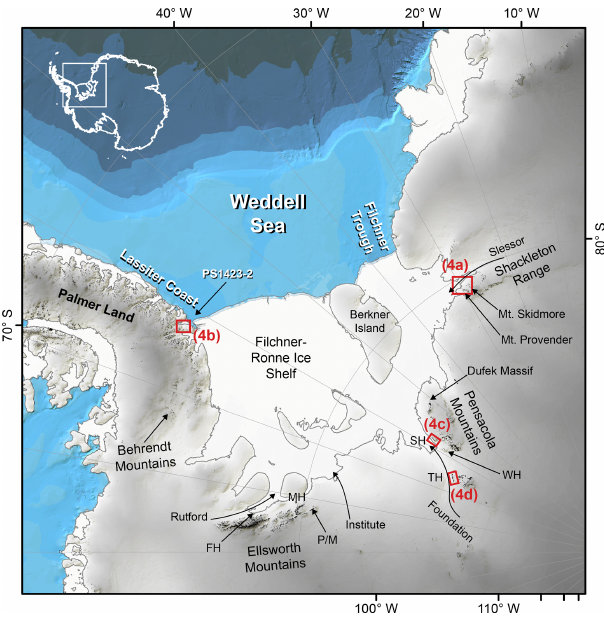
Figure 1. The Weddell Sea Embayment, including all locations referred to within the text. SH, WH, and TH are the Schmidt, Williams, and Thomas Hills, respectively. FH, P/M, and MH are the Flower Hills, Patriot and Marble Hills, and the Meyer Hills, re- spectively. Black is exposed rock. Red boxes show extent of satel- lite images in Fig. 4. Exposed rock and coastline sourced from the SCAR Antarctic Digital Database. Bathymetry sourced from the International Bathymetric Chart of the Southern Ocean V1.0 (IB- SCO; Arndt et al., 2013). Surface topography (shading) is sourced from the Reference Elevation Model of Antarctica (REMA; Howat et al., 2019). PS1423-2 is a marine sediment core from Crawford et al.